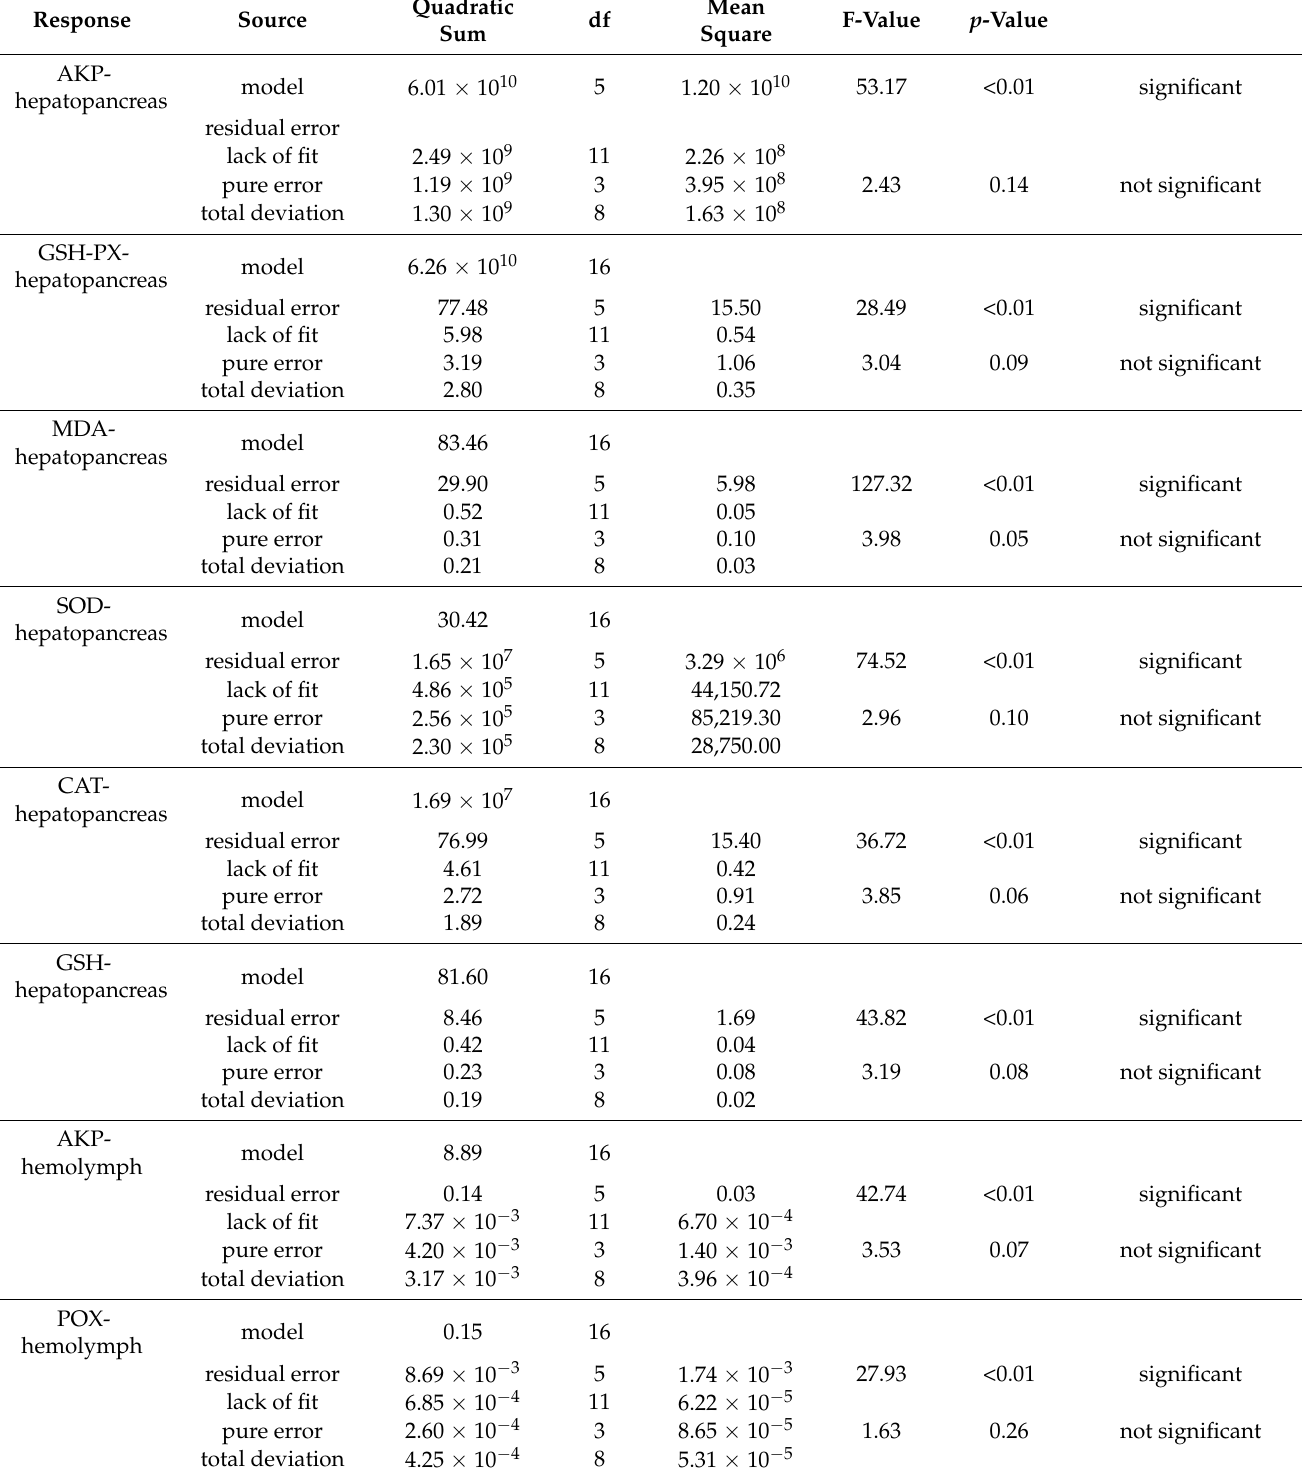
Table 5. Model variance analysis of immune and antioxidant